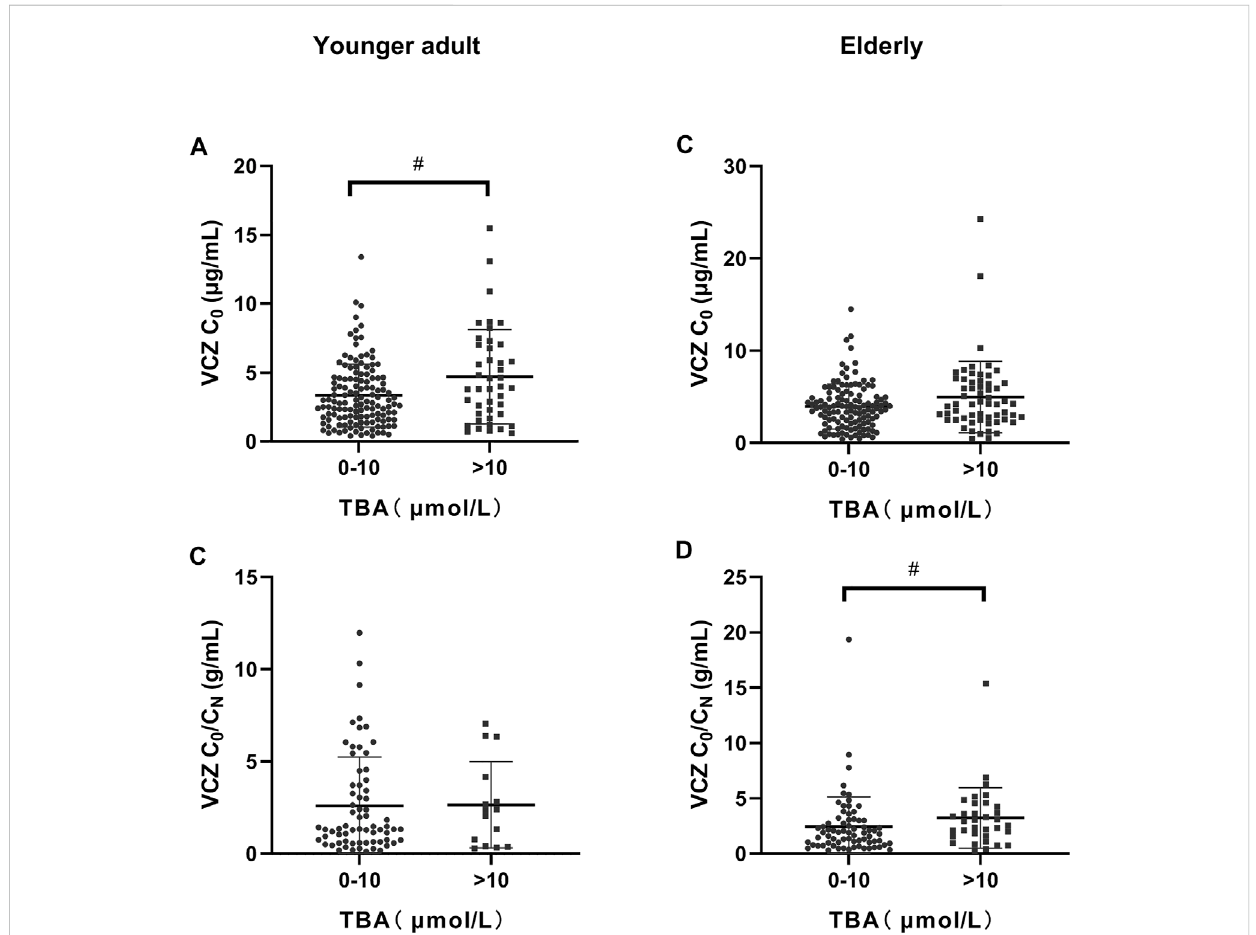
FIGURE 2 Distribution of voriconazole (VCZ) trough concentration (C 0 ) and the VCZ-to-VCZ N-oxide concentration ratio (C 0 /C N ) according to total bile acid (TBA)level. (A) .VCZC 0 inyoungeradultpatientswassigni fi cantlyincreasedwhenTBAlevelswerehigherthan10 μ mol/L; (B) .VCZC 0 /C N inyoungeradult patients was similar when TBA levels were between 0 and 10 μ mol/L and higher than 10 μ mol/L; (C) . VCZ C 0 in elderly patients was similar when TBA levels were between 0 and 10 μ mol/L and greater than 10 μ mol/L; (D) . VCZ C 0 /C N in elderly patients increased signi fi cantly when TBA levels were higher than 10 μ mol/L. # p <